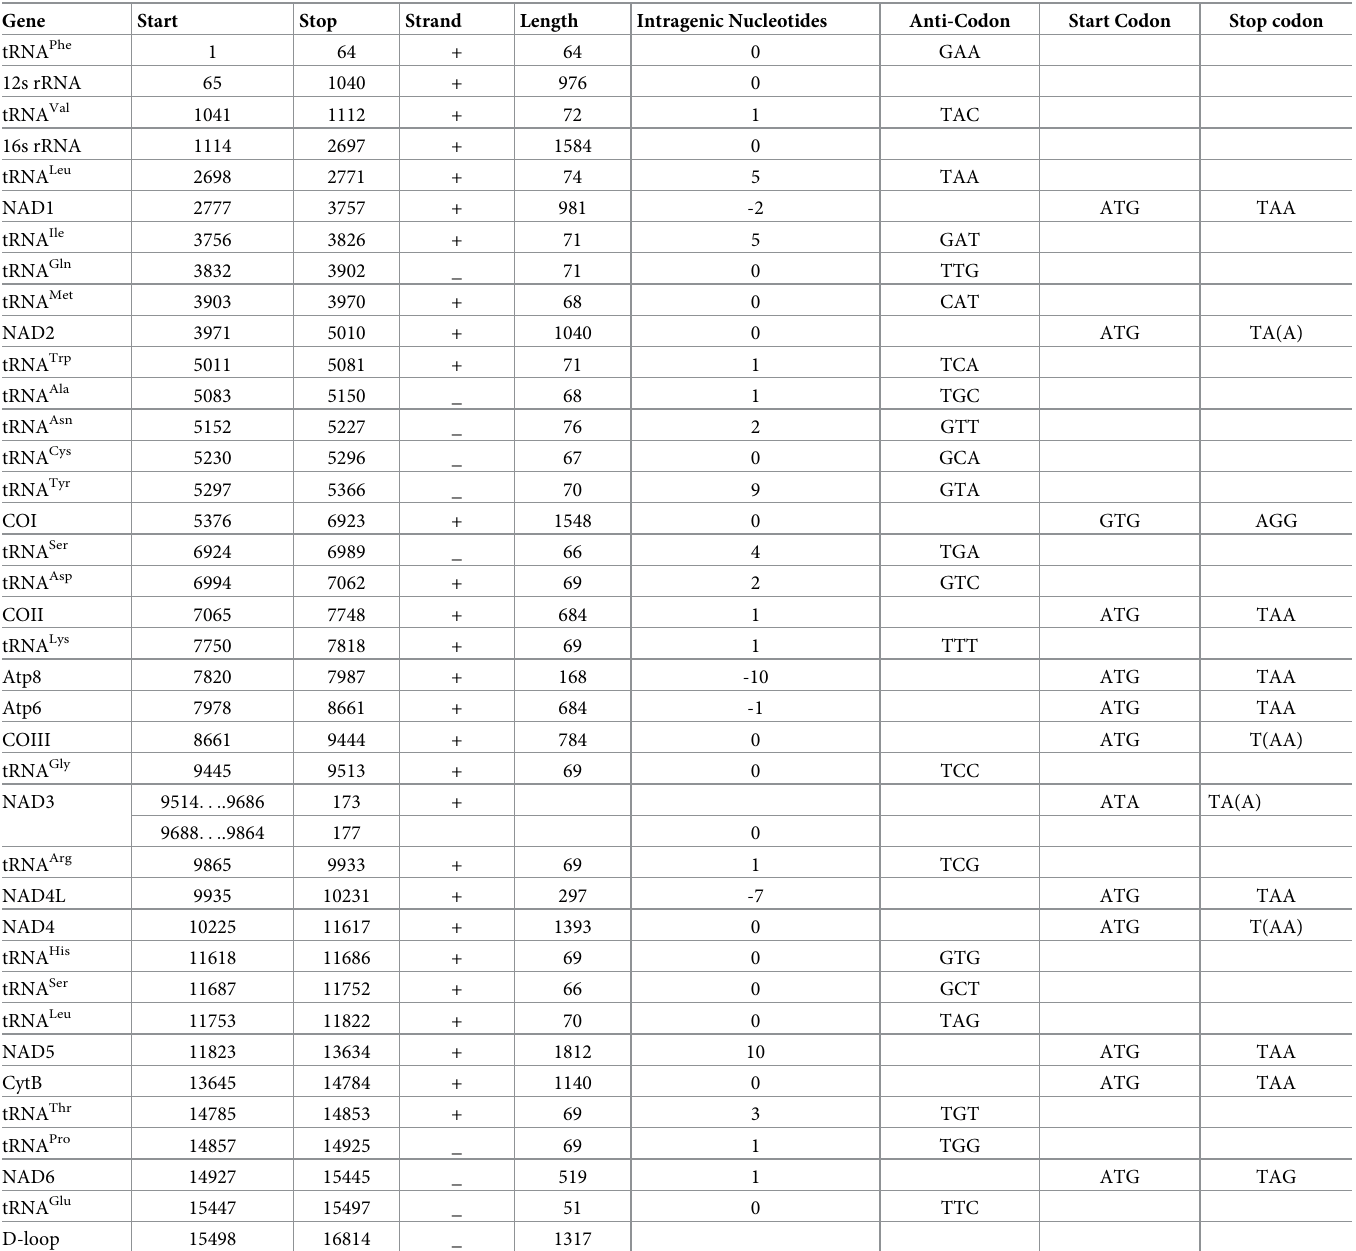
Table 2. Summary of Psittacula cyanocephala